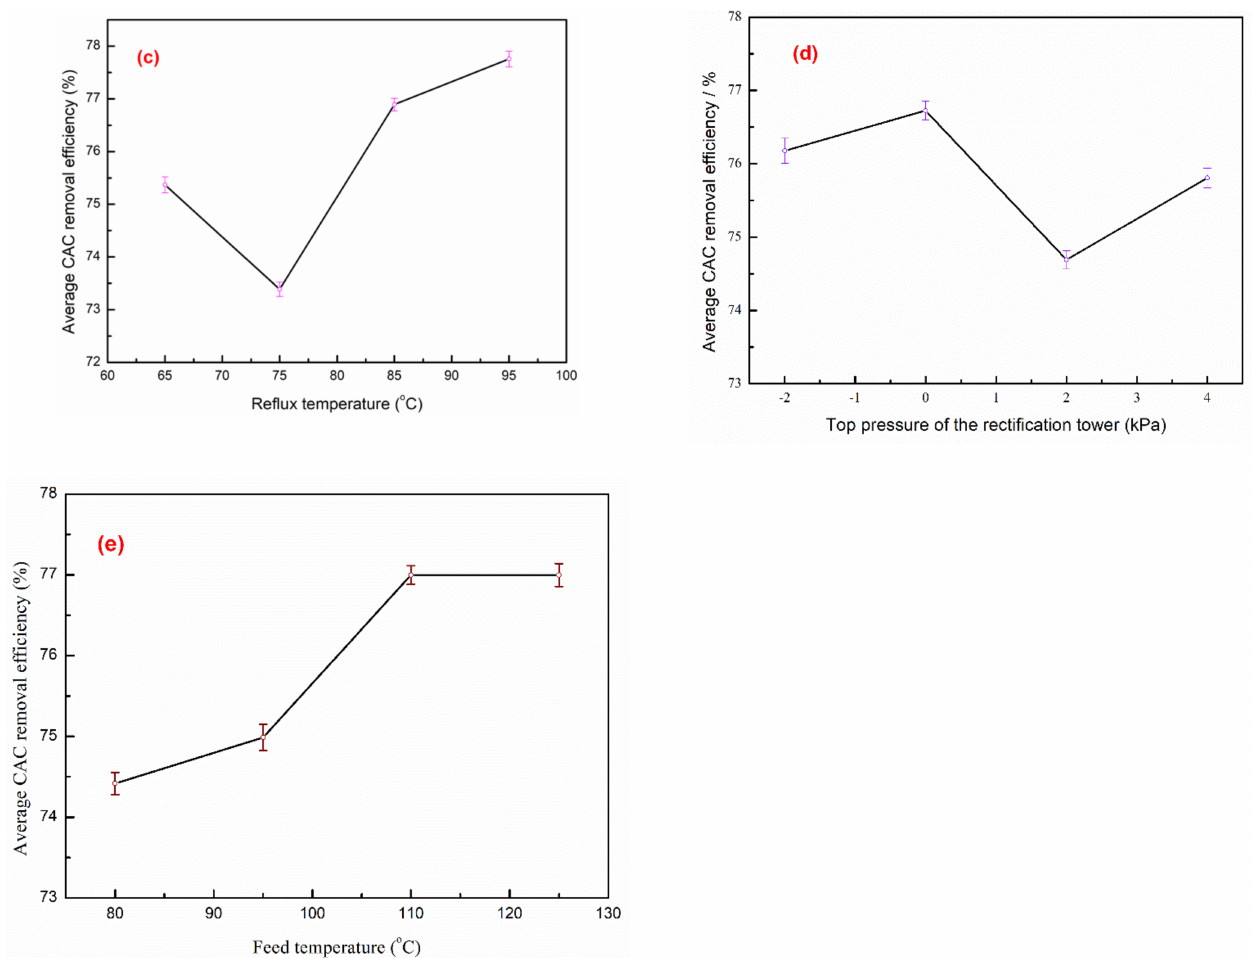
Figure 7. The influence of different factors on CAC removal efficiency: ( a ) heating power, ( b ) reflux ratio, ( c ) reflux temperature, ( d ) top pressure of the rectification tower, and ( e ) feed temperature.